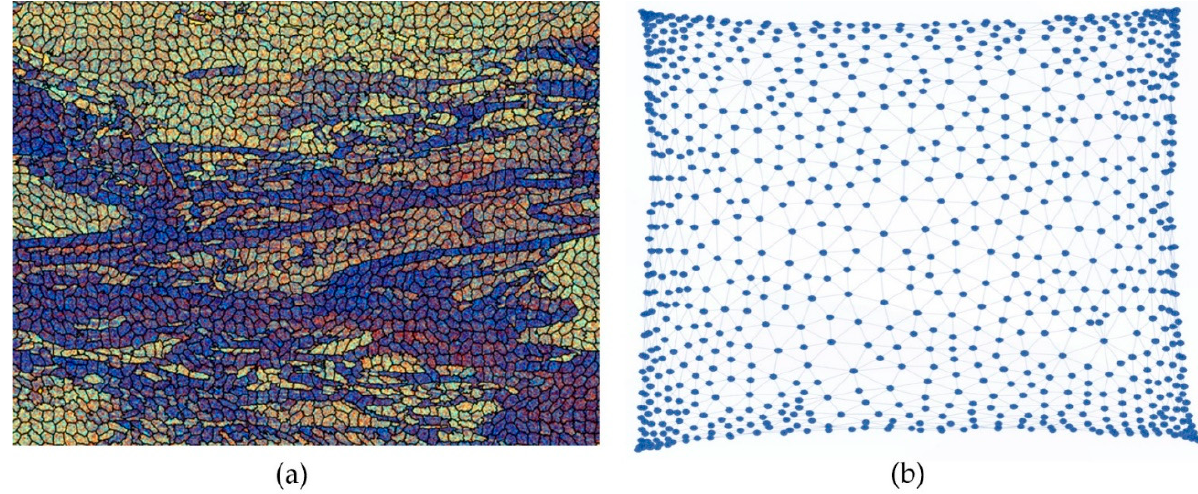
Figure 9. Constructed graph data from image. ( a ) Superpixels on the PolSAR image; ( b ) visualization of graph data.